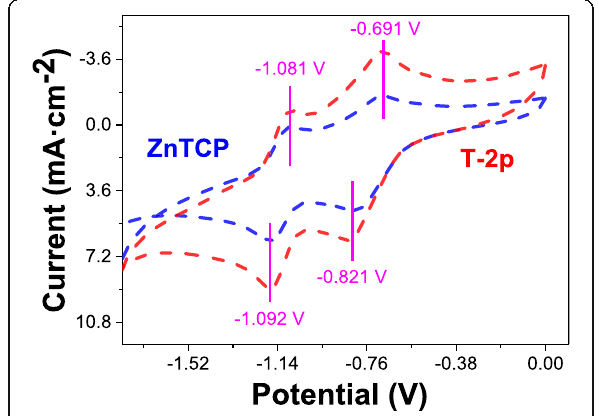
Fig. 11 The C t /C 0 vs. time curves of different reactive species scavengers on the photodegradation of RhB under visible-light